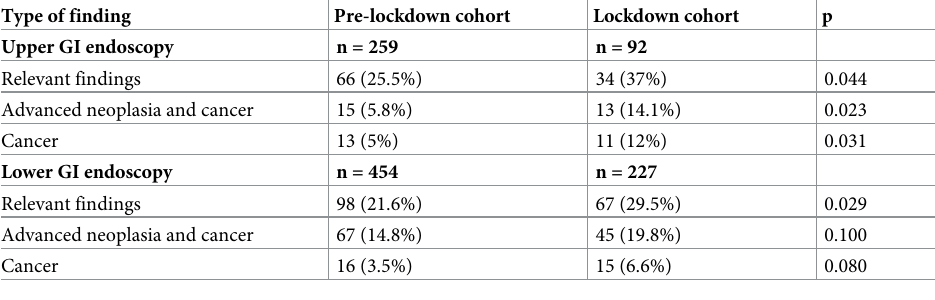
Table 3. Endoscopic findings in each cohort according to upper and lower gastrointestinal (GI)